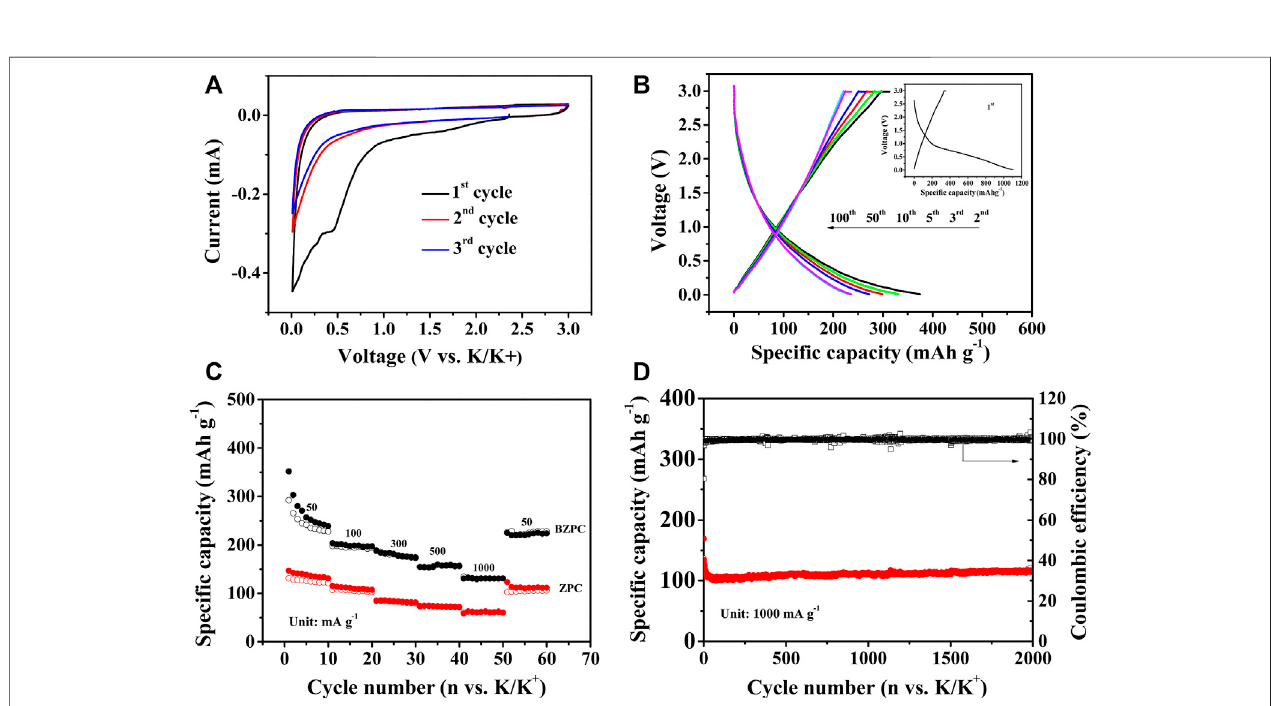
Frontiers in Chemistry |